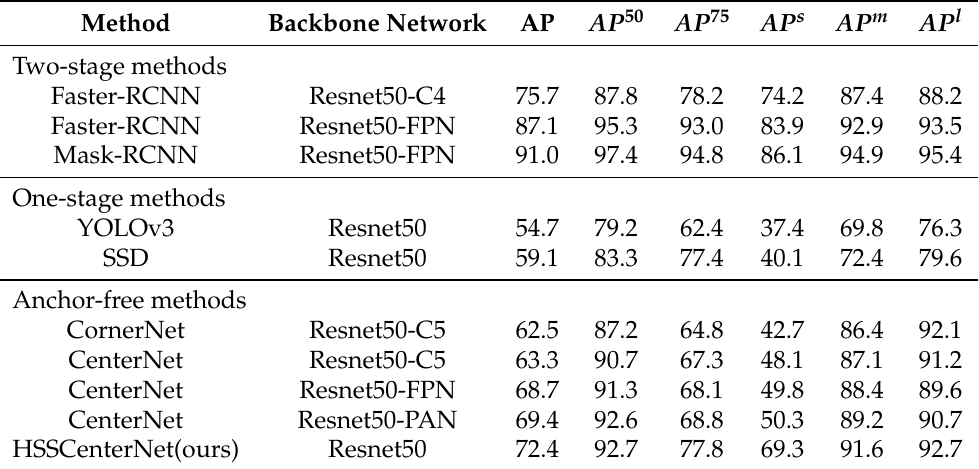
Table 5. Test results on the Airbus ship dataset.